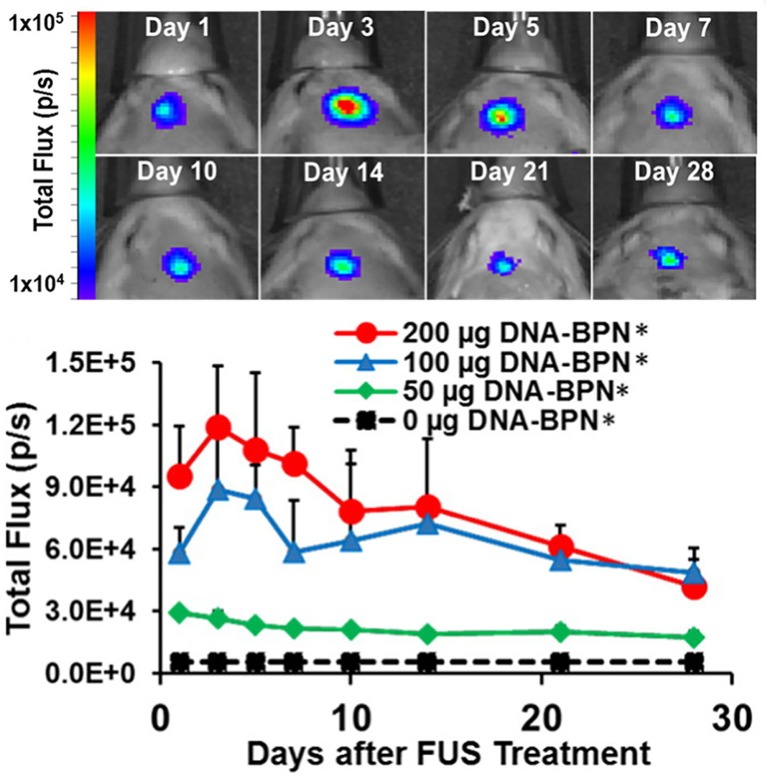
FUS-mediated delivery of reporter gene-bearing non-vial nanoparticles (DNA-BPN) across the BBB leads to robust and localized transgene expression in the rat brain. Top: Representative IVIS bioluminescence images after DNA-BPN delivery to rat brain using FUS and MBs. Bottom: Line graph of bioluminescence total flux over the 28-day test period. n = 5 at each dose. *Significantly different than all other doses tested (p < 0.05). Adapted from Mead et al. (2016). Reproduced with permission.